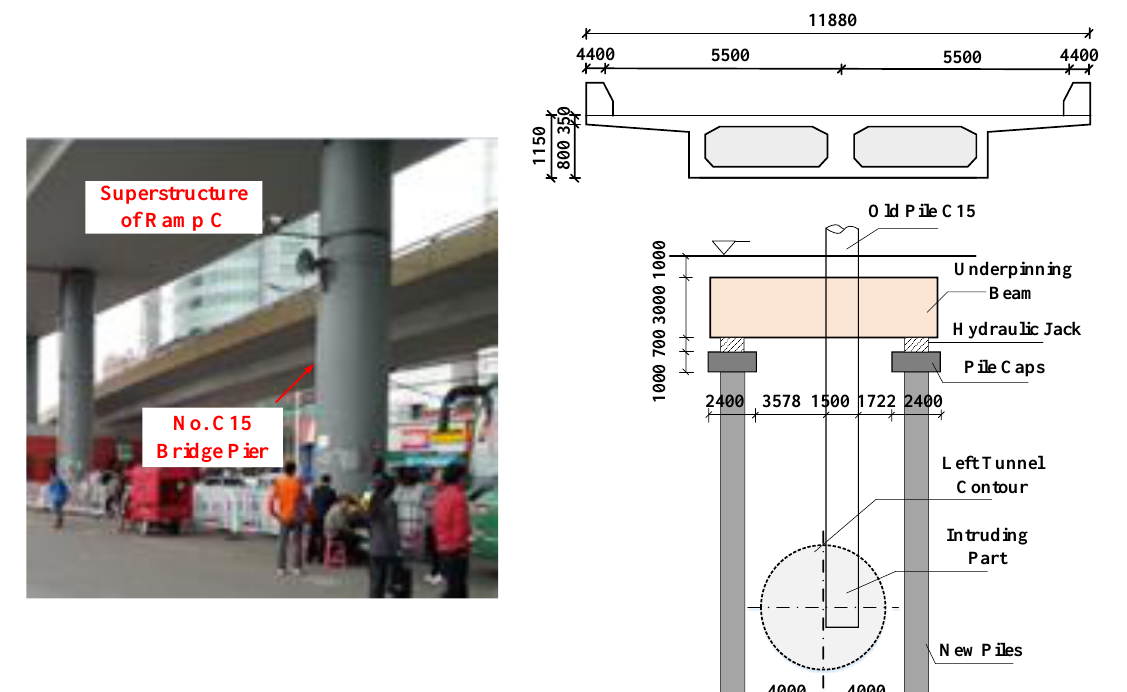
Figure 2. Pile underpinning scheme of C15 bridge pier and the corresponding parameters.